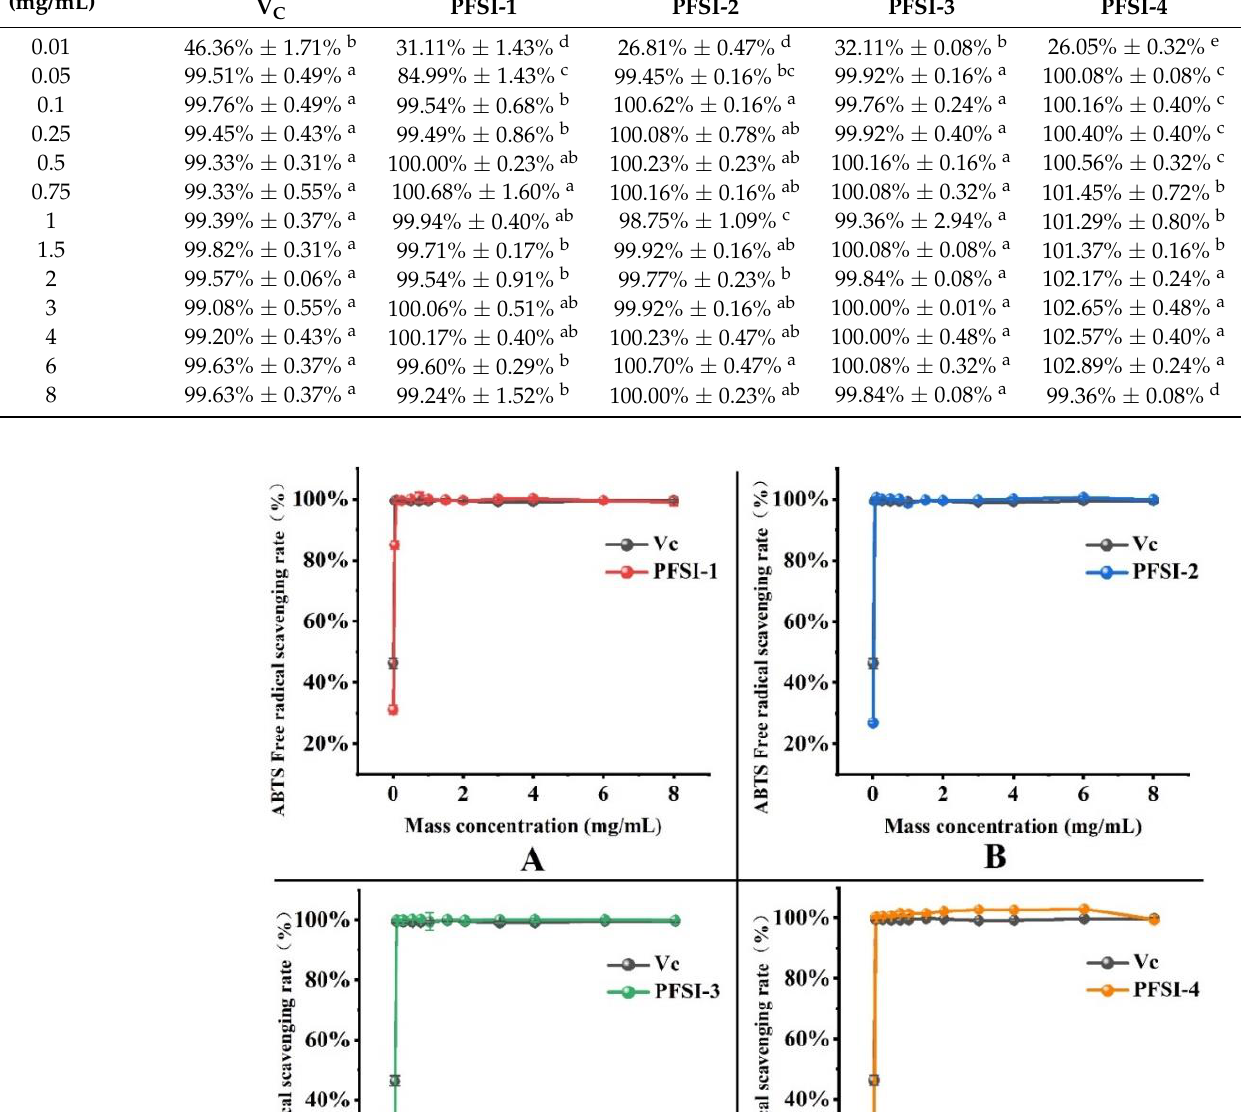
Table 6. ABTS · free radical scavenging by PFSI-1, PFSI-2, PFSI-3, and PFSI-4. (Note: same lower- case letters indicate no significant difference between groups, different lowercase letters indicate a significant difference between groups, p < 0.05).